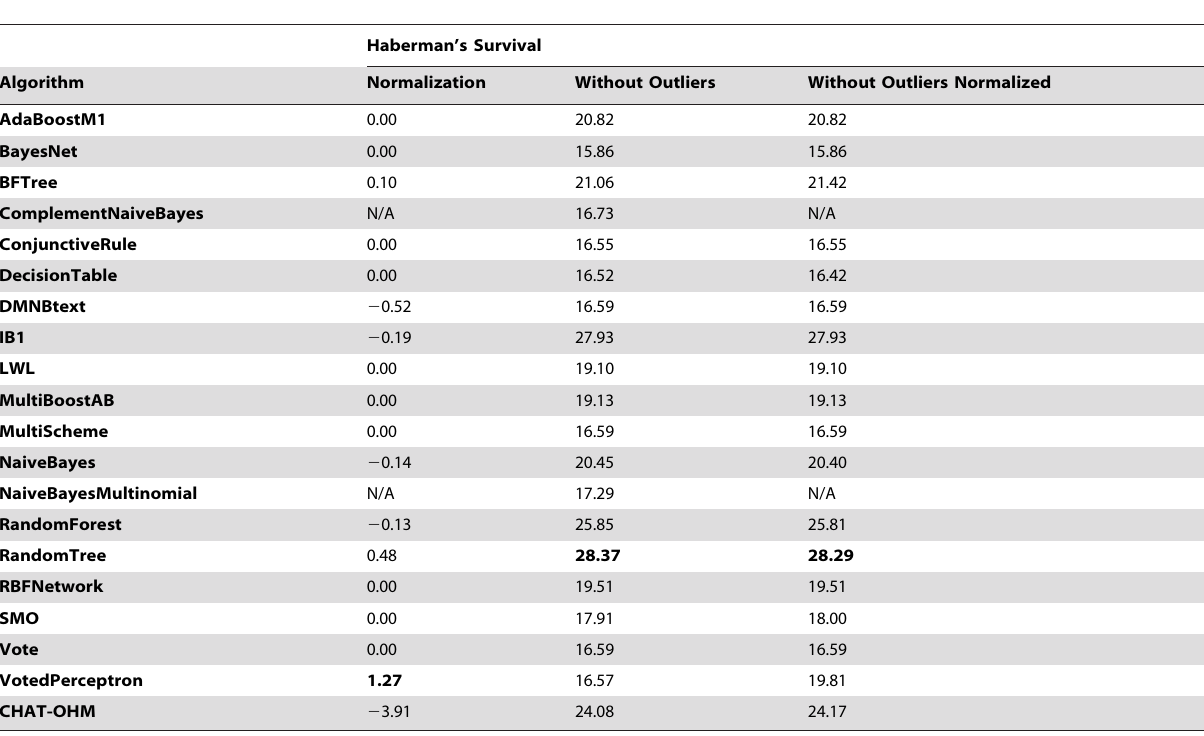
Table 9. Comparison of classification improvement (%) for haberman’s survival